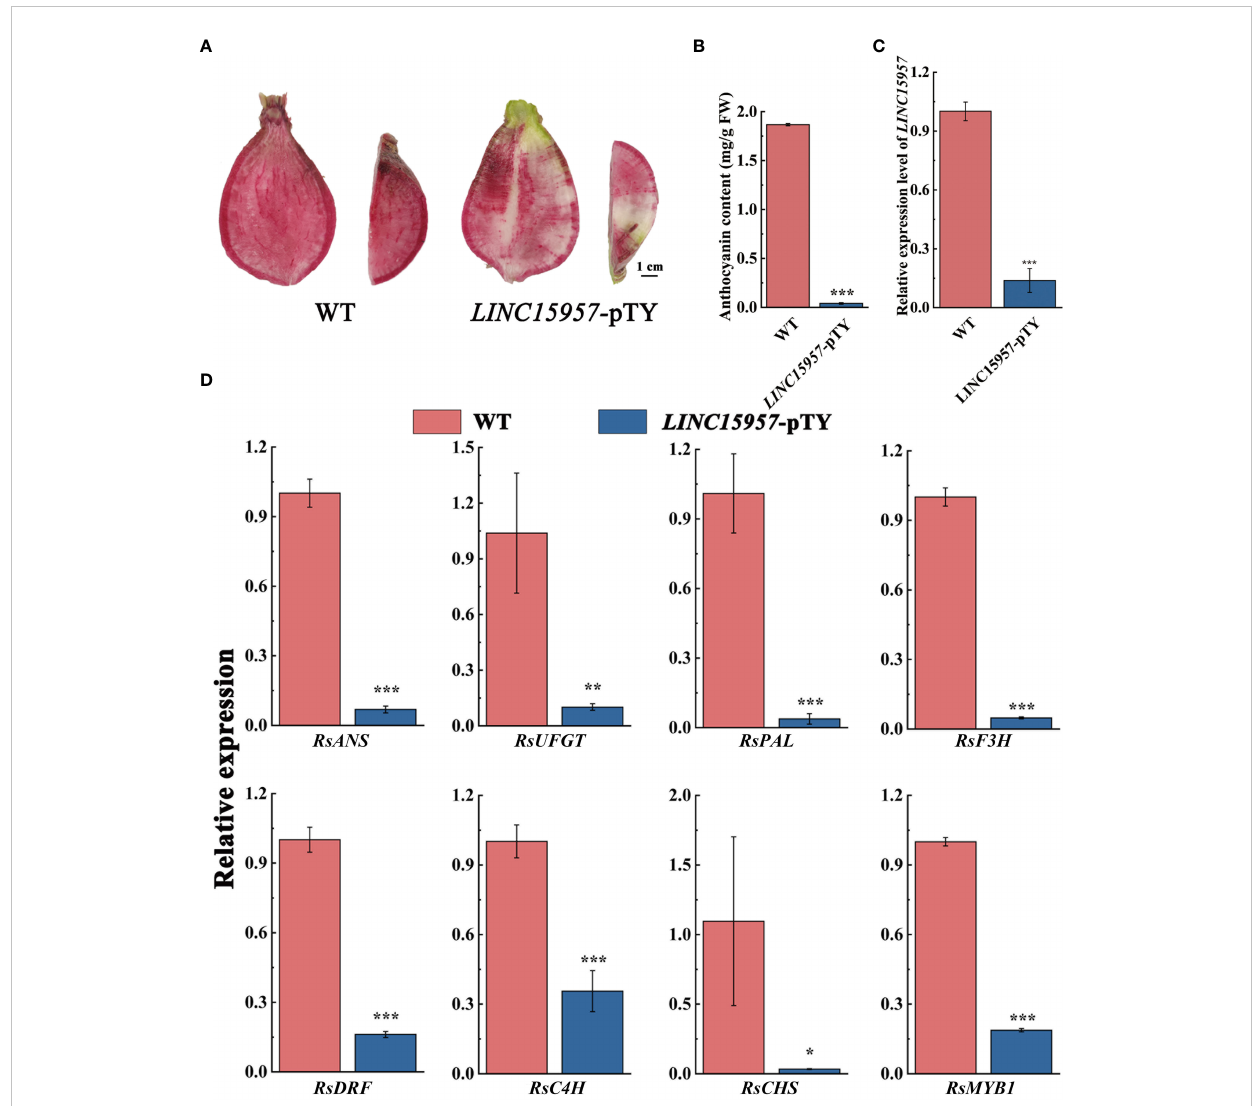
FIGURE 3 Viral induced silencing of the LINC15957 genes in radish fl esh. (A) Radish were inoculated with pTY (WT) or LINC15957 -pTY (from left to right). Photographs of root were taken at 4 week post-inoculation. (B) Anthocyanin content in the tissue of injection empty and LINC15957 -pTY. (C) The gene expression level in LINC15957 -pTY. (D) Expression pattern of key anthocyanin biosynthetic genes in LINC15957 -pTY. RsACTIN was used as reference gene for normalization. Error bars represent the mean ± SE of three biological replicates. *p < 0.05, **p < 0.01, ***p < 0.001, Student ’ s